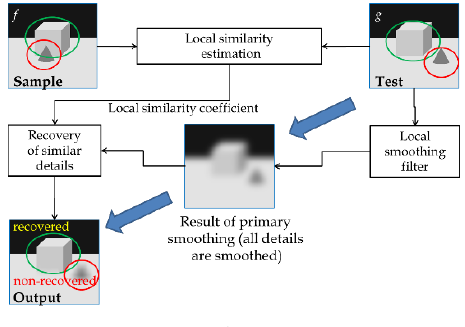
Figure 1. The scheme of local guided